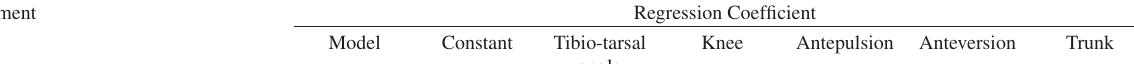
Table 1 - Significance levels of our multiple regression model for the displacement of body segments during backward postural perturbation (BPP) and forward postural perturbation (FPP) with body segment positions in the initial and final frames of the respective postural perturbations. Significance levels are listed for body segments for the accepted